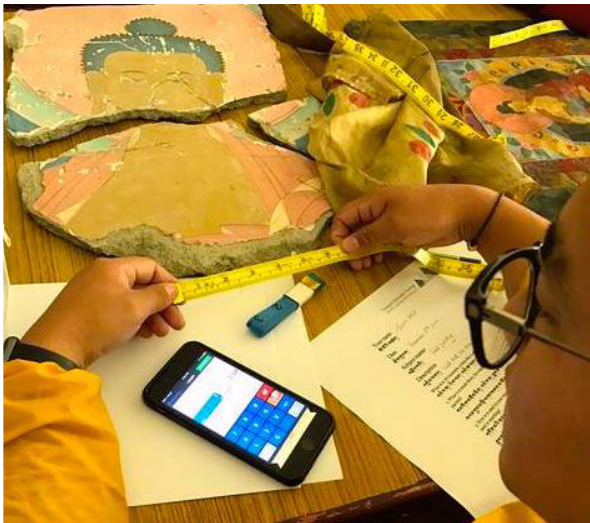
Figure 2. Monk in Nepal documents fragments of wall